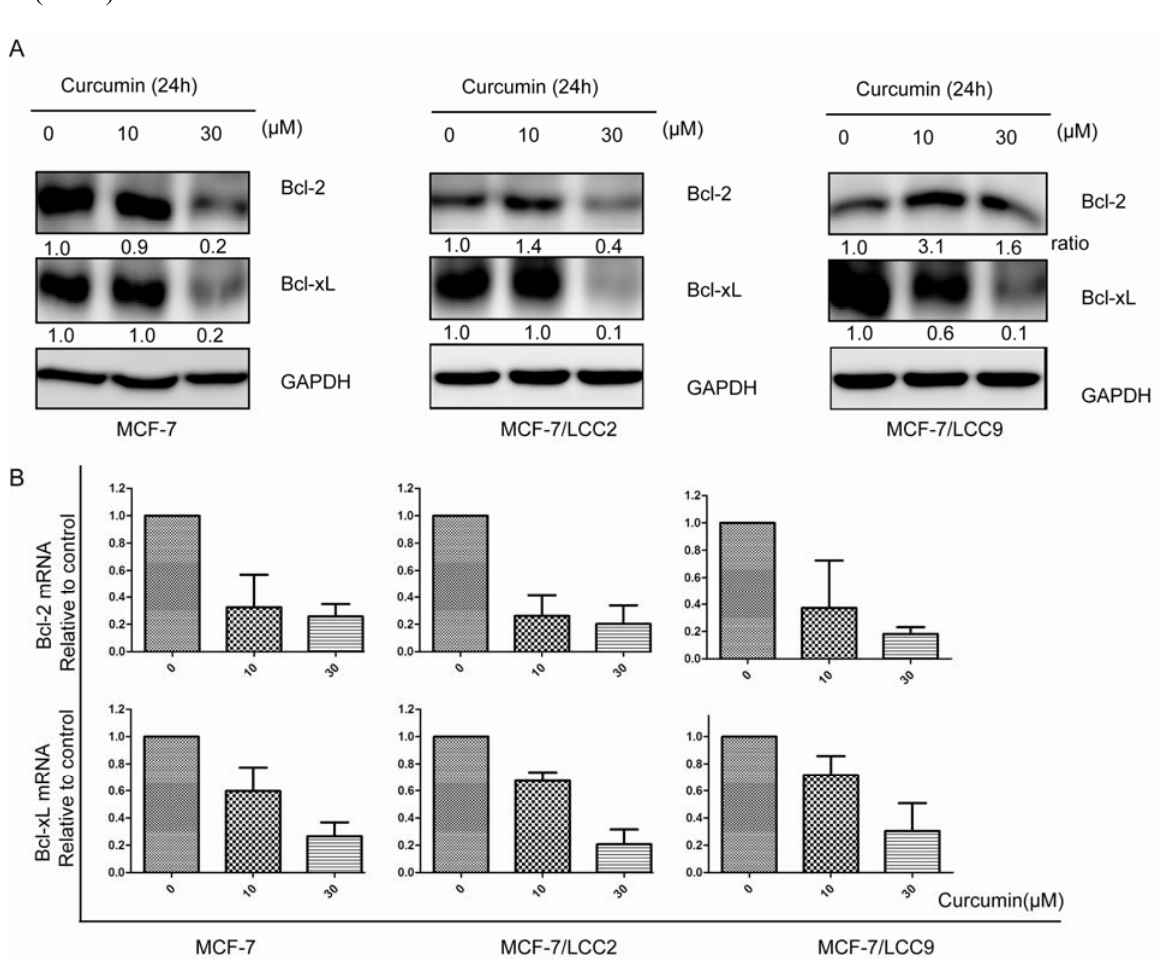
Figure 6. Curcumin suppresses cell survival signals in protein and mRNA levels in MCF-7/LCC2 and MCF-7/LCC9. ( A ) Lysates from curcumin (10 and 30 μ M) treatment for 24 h with western blot revealed significant reduction in expression of Bcl-2 and Bcl-xL protein levels in sensitive and resistant cells; ( B ) Real-time PCR showed the similar trend in downregulation of Bcl-2 and Bcl-xL in mRNA levels. Data are presented as mean ± SD (n =